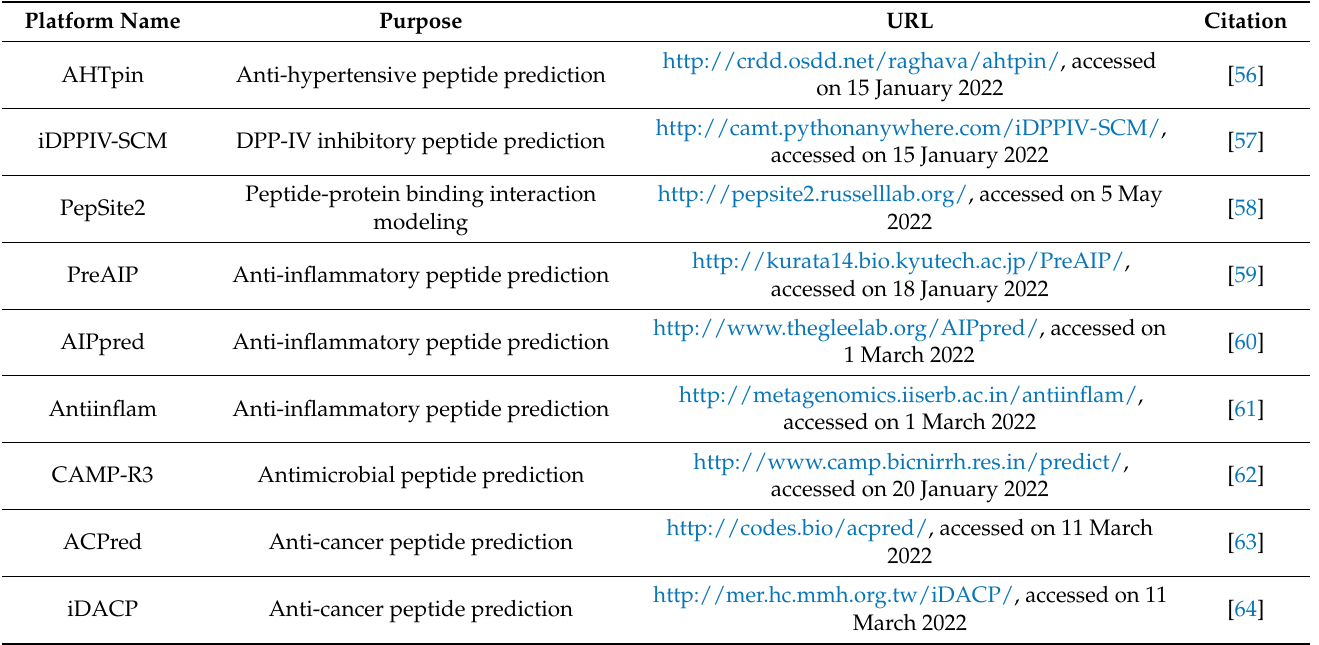
Table 7. Bioactivity prediction servers and databases used for bioactivity screening in the current